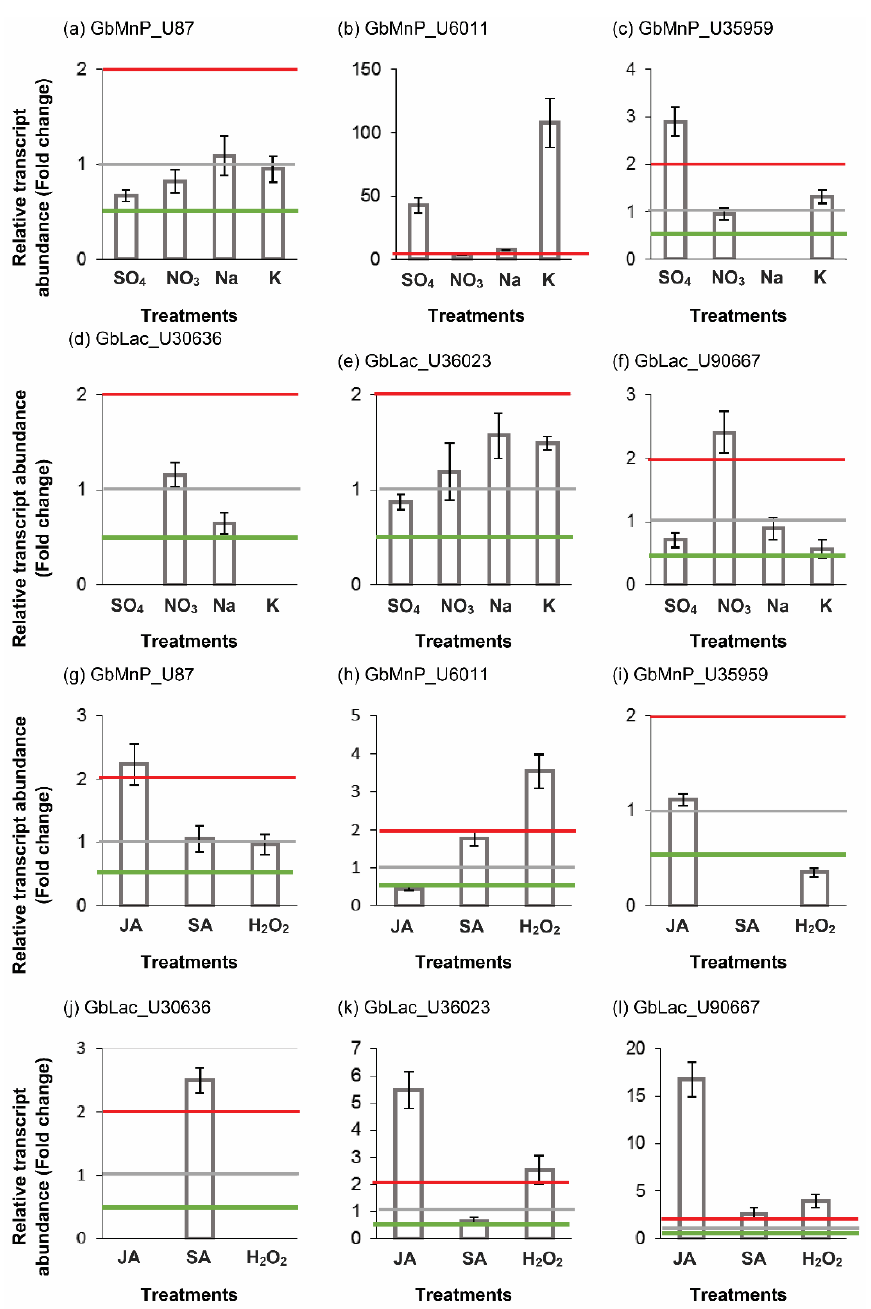
Figure 5. Relative expression of GbMnPs and GbLacs in G. boninense in response to different nitrogen sources ( a – f ), phytohormones and hydrogen peroxide ( g – l ). Ammonium sulphate (SO 4 ); ammonium nitrate (NO 3 ); sodium nitrate (Na); potassium nitrate (K); jasmonic acid (JA); salicylic acid (SA); hydrogen peroxide (H 2 O 2 ). Red dotted lines indicate up-regulation. Green lines indicate 2-fold down-regulation. Grey lines are the normalized expression levels for untreated G. boninense that were grown in either Czapek – Dox broth (control for nitrogen treatments) or PDB (control for JA, SA and hydrogen peroxide treatments).